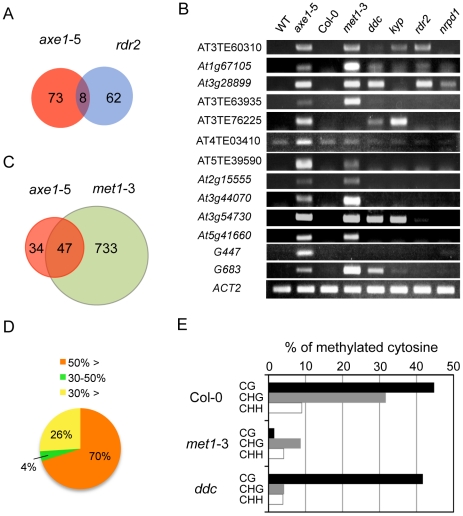
HDA6-mediated gene silencing requires MET1 but not RdDM
pathway.(A) A Venn diagram showing the small fraction of overlap between the AGI
genes upregulated in axe1-5, compared with those in
rdr2. The AGI genes identified as upregulated in
rdr2 in a previous genome-wide transcriptional
profiling experiment [43], were compared with the AGI genes upregulated
in axe1-5 identified in this study. (B) Various mutants
deficient in gene silencing, such as the chromatin modifying enzymes
(hda6, met1, ddc,
and kyp) and siRNA production (rdr2
and nrpd1) were examined for the activation of
representative HDA6 target loci (AT3TE60310, At1g67105,
At3g28899, AT3TE63935, AT3TE76225, AT4TE03410,
AT5TE39590, At2g15555, At3g44070,
At3g54730, At5g41660,
G447 and G683) by RT-PCR analysis.
ACT2 served as a control. The MET1 requirement for
repression of HDA6 target loci is highlighted. (C) A
Venn diagram showing the significant overlap between the AGI genes
upregulated in axe1-5 and in met1-3
that were identified in genome-wide transcriptional profiling. (D) The
DNA methylation status in wild-type Col-0 for the genes upregulated in
axe1-5. The fraction of AGI genes associated with
DNA methylation at more than 50% of methylated cytosines around
TSS (−500 to +500 from TSS) was determined using publicly
available datasets of methylcytosine immunoprecipitation [13].
(E) Cytosine methylation was investigated in each sequence context (CG,
CHG, and CHH) in wild-type Col-0, met1-3, and
ddc using publicly available datasets of cytosine
methylation (methylC-seq, [13]). The percentages
of methylated cytosines of the AGI genes upregulated in
axe1-5 are shown.